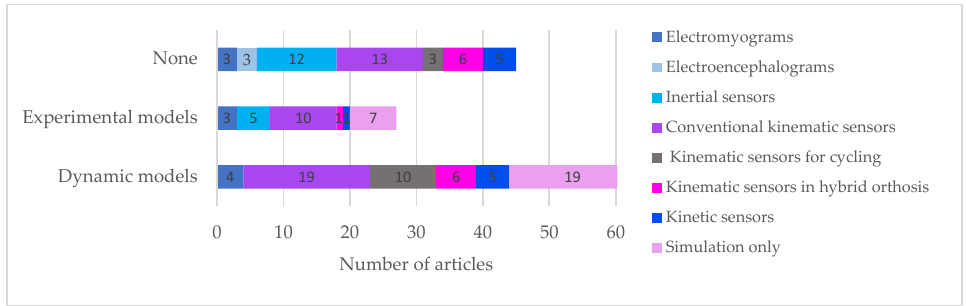
Figure 5 . Dynamic vs. experimental models depending on the type of sensor. Figure 5. Dynamic vs. experimental models depending on the type of